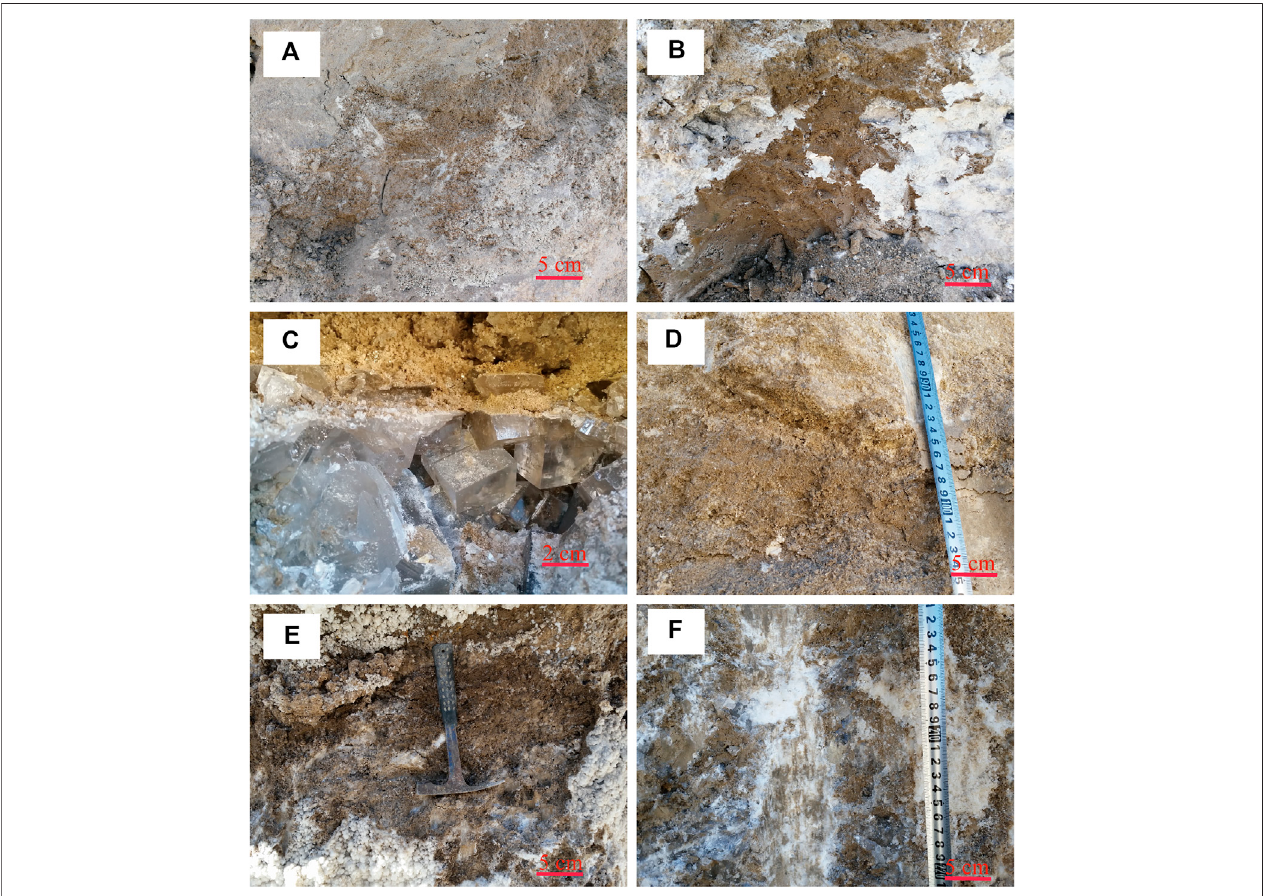
FIGURE3| Lithologicalcharacteristicsofthesectioninstudyarea.Theuppersection( (A,B) ,2.70 mindepth)iscomposedwithbrowntodarkbrown fi nesandand halite,withathinlymirabilitedepositedonthesectionsurface.Thelowersection(from5.70to2.70 mupwards)ischaracterizedas (C) agreyclay-bearinghalitelayerwith large halite crystals ( ∼ 0.3 – 1.5 cm diameter); (D) a white to grey salt-containing sand layer, local white polyhalite lenses existed; (E,F) a horizontal polyhalite-enriched sublayer was the main polyhalite formation layer.